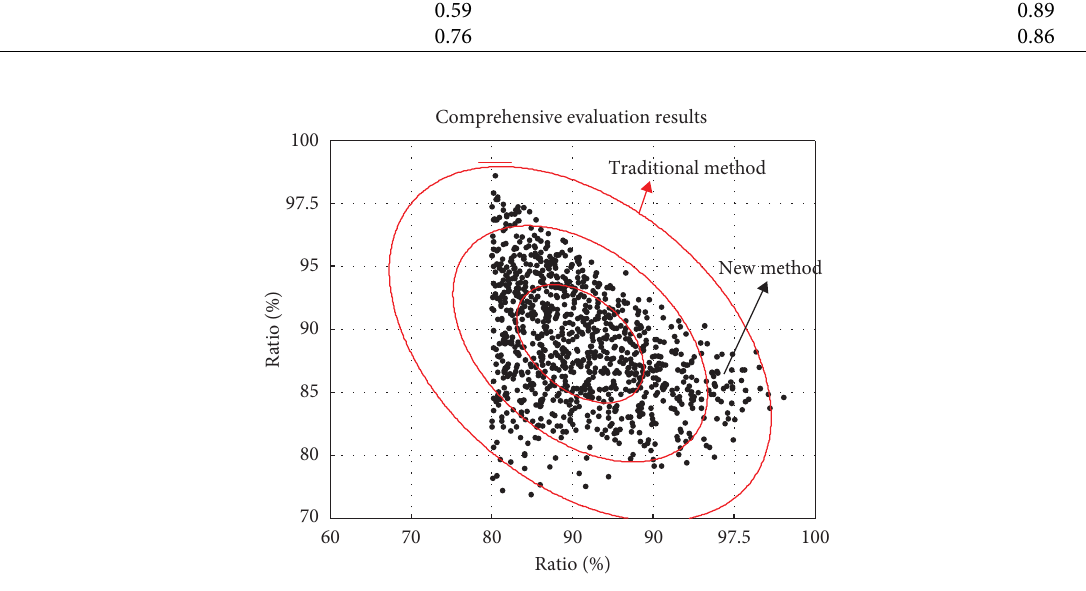
Figure 9: The experiment results of complex background scene.